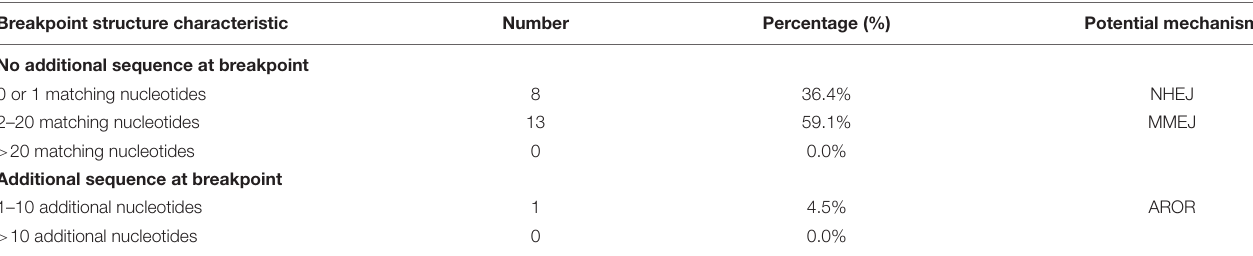
TABLE 3 | Breakpoint structure characteristics and potential mechanisms.